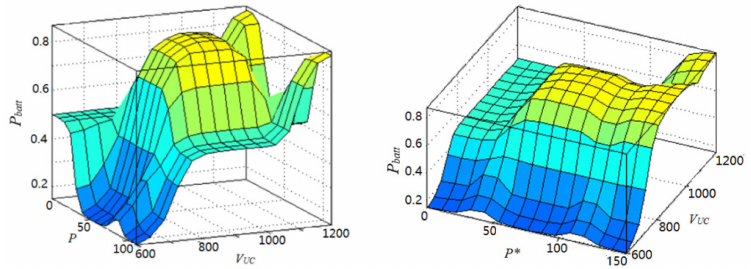
Figure 23. The relationship between the input and output of mode